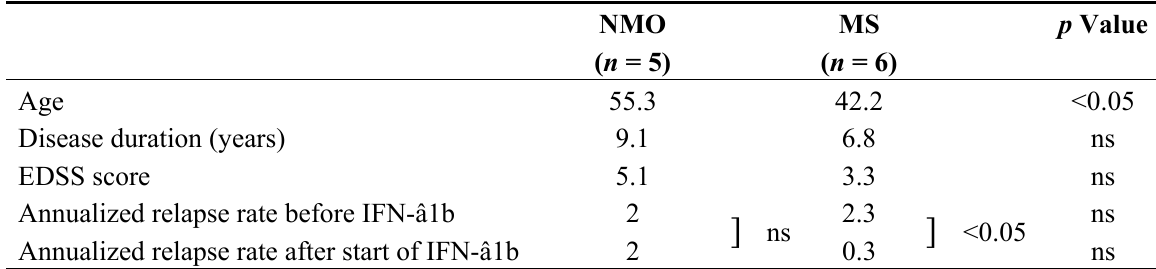
Table 2. Demographic features of neuromyelitis optica (NMO) and multiple sclerosis (MS) patients treated with Interferon â (IFN-â1b) longitudinaly.